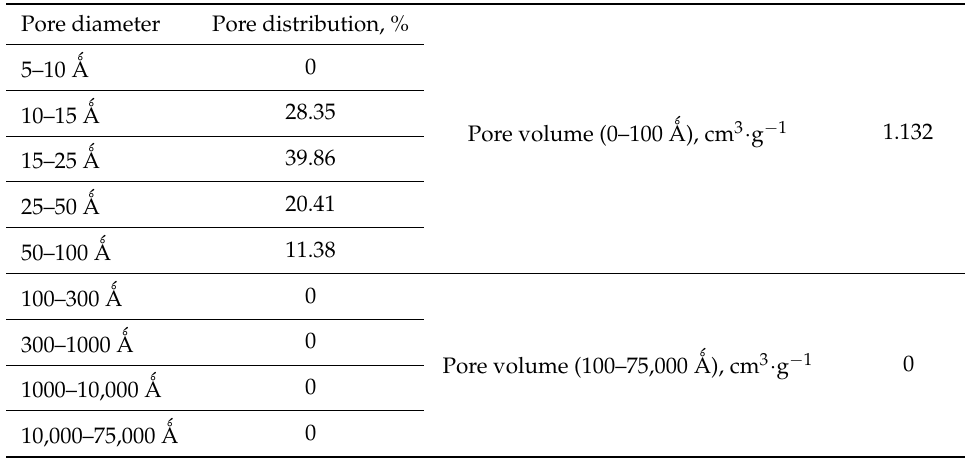
Table 4. Activated charcoal pore size distribution.